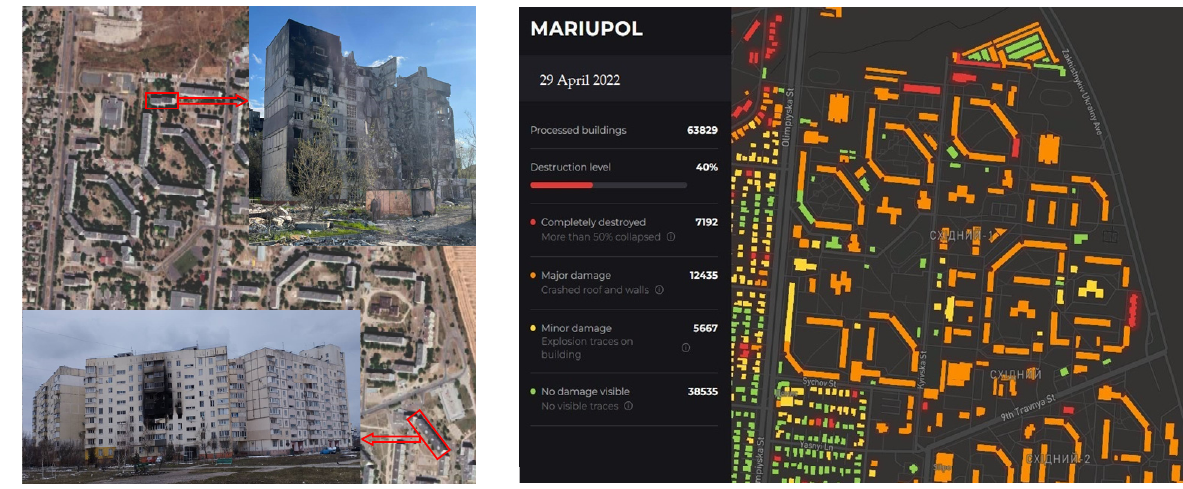
Figure 4. Destruction and damage to large-panel buildings of the Skhydnyi district in Mariupol city, Donetsk region [11,12].